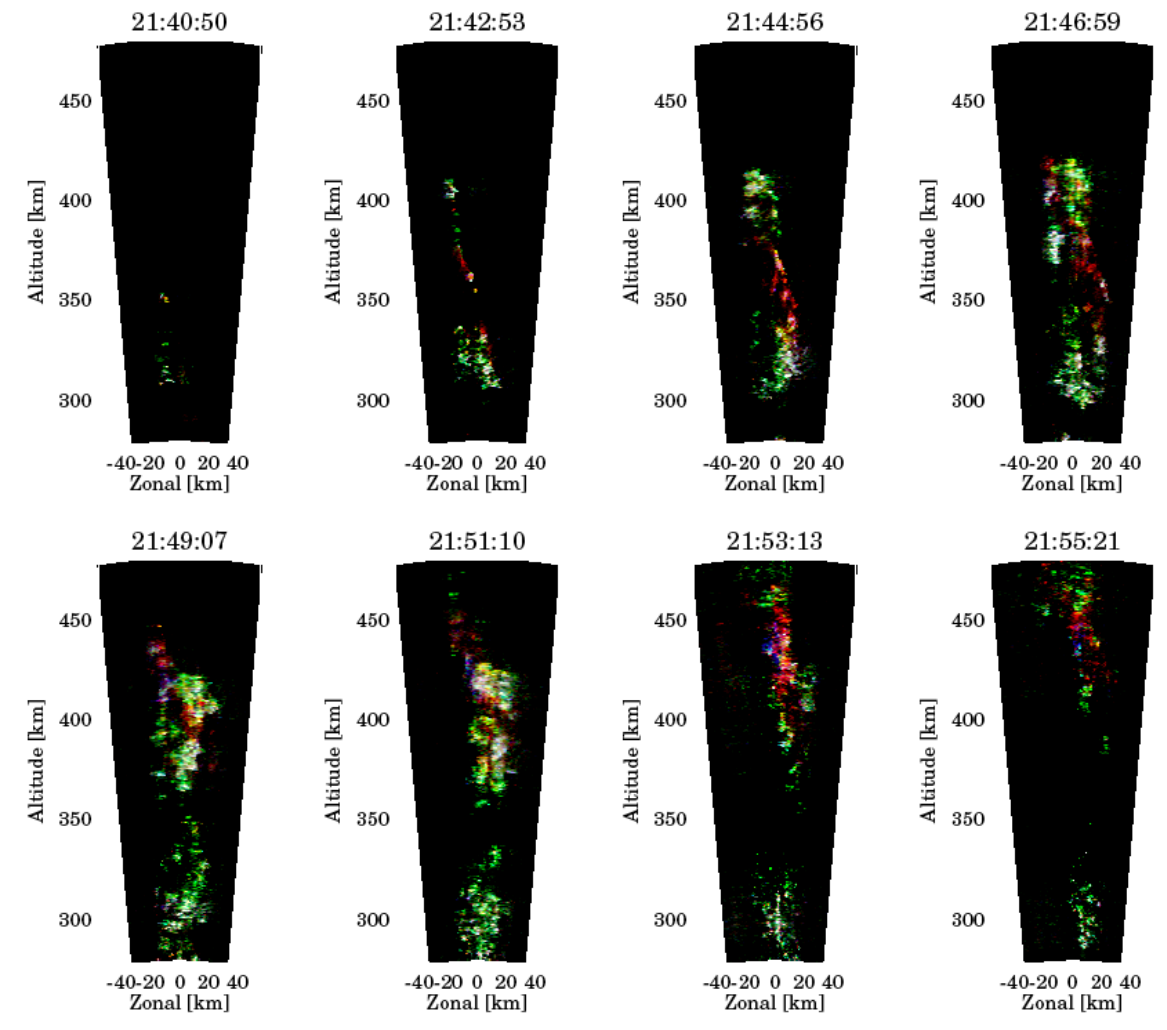
Fig. 7. Example of ESF images showing depleted channels pinching off a bottomside layer. Each frames has been obtained with 10s exposure. Note that the red depleted channels move independently of the surrounding regions that in general drift